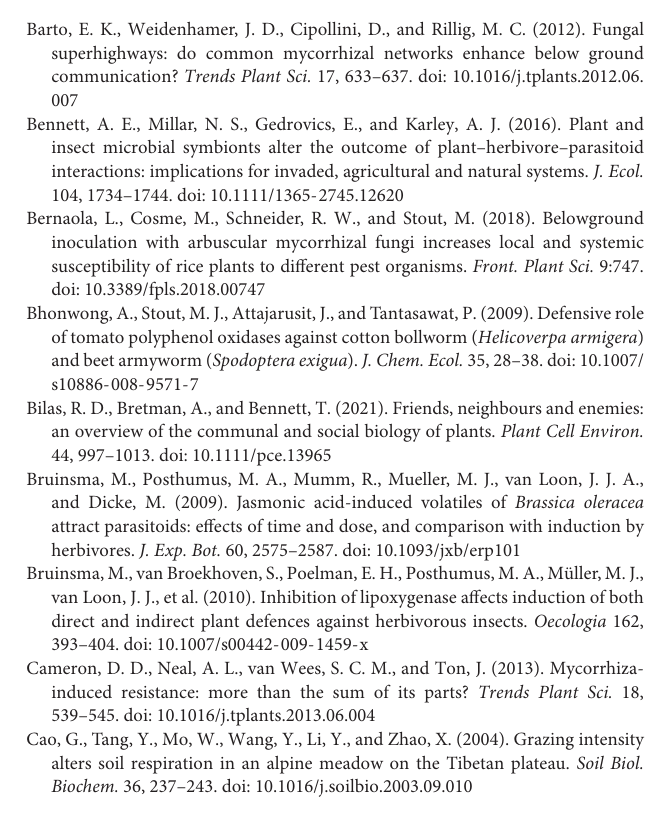
Supplementary Figure S1 | The chromatograms of (1-Methylpropyl)benzene. Supplementary Figure S2 | The chromatograms of 1-Methyl-2- phenylcyclopropane. Supplementary Figure S3 | The chromatograms of 2,5-Dimethylacetophenone. Supplementary Figure S4 | The chromatograms of 2,5-dimethylethylbenzene. Supplementary Figure S5 | The chromatograms of 2-Phenyl-1-propanal. Supplementary Figure S6 | The chromatograms of 2-Propenal. Supplementary Figure S7 | The chromatograms of 4-Acetyl-m-xylene. Supplementary Figure S8 | The chromatograms of 4-Ethyltoluene. Supplementary Figure S9 | The chromatograms of Cumene, p-ethyl-. Supplementary Figure S10 | The chromatograms of Cumene. Supplementary Figure S11 | The chromatograms of Ethyl-benzaldehyde. Supplementary Figure S12 | The chromatograms of Isobutenylbenzene. Supplementary Figure S13 | The chromatograms of Isopropyl palmitate. Supplementary Figure S14 | The chromatograms of p-Cymene. Supplementary Figure S15 | The chromatograms of Phenethyl